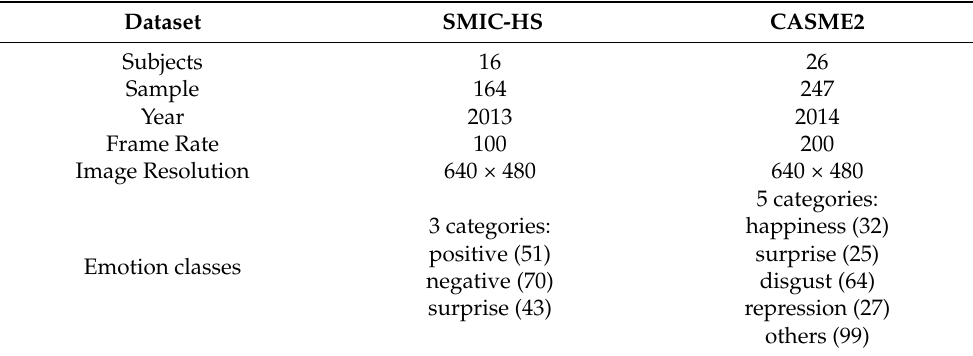
Table 2. Detailed information of SMIC and CASME2